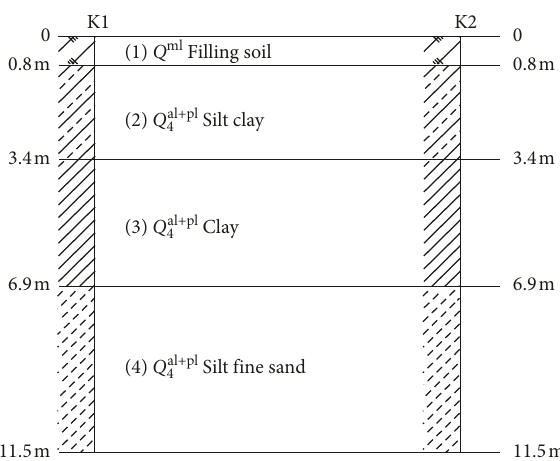
Figure 1: Soil profile of the test site.